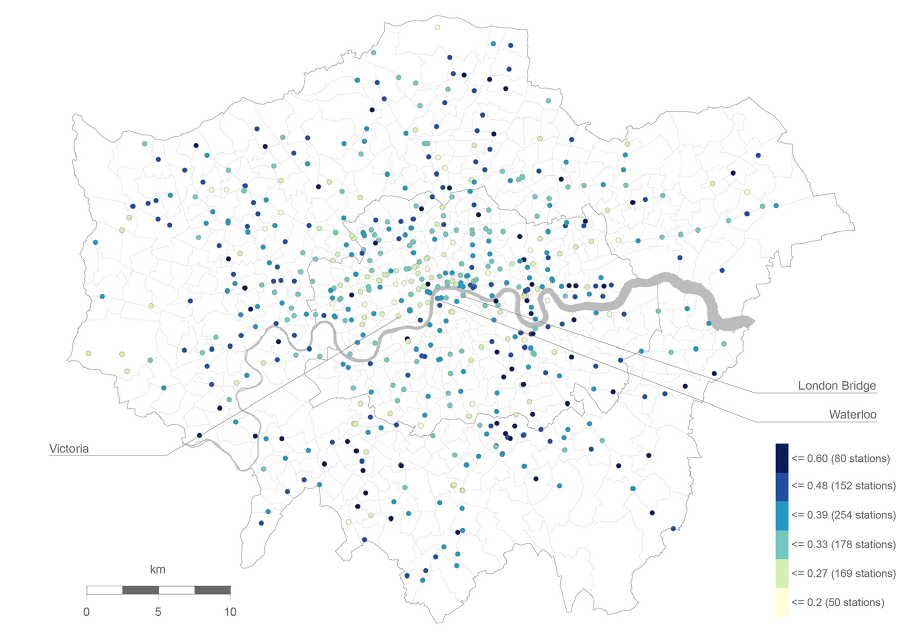
Figure 4: Spatial distribution of the variability calculated for an average week day.